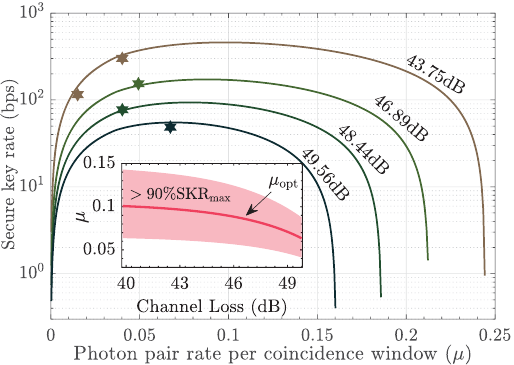
Fig. 5 Achievable secure key rates over a single free-space link. The solid lines are model calculations for four different average total link attenuations corresponding to fi ve of our measurements (stars). While the maximal achievable secure key rate SKR max decreases for increasing attenuation, the optimal photon pair rate μ opt to achieve SKR max shifts to lower pair rates. The inset illustrates this tendency and highlights the tolerance ( ⩾ 90% of SKR max ) to pair rate fl uctuations around μ opt .